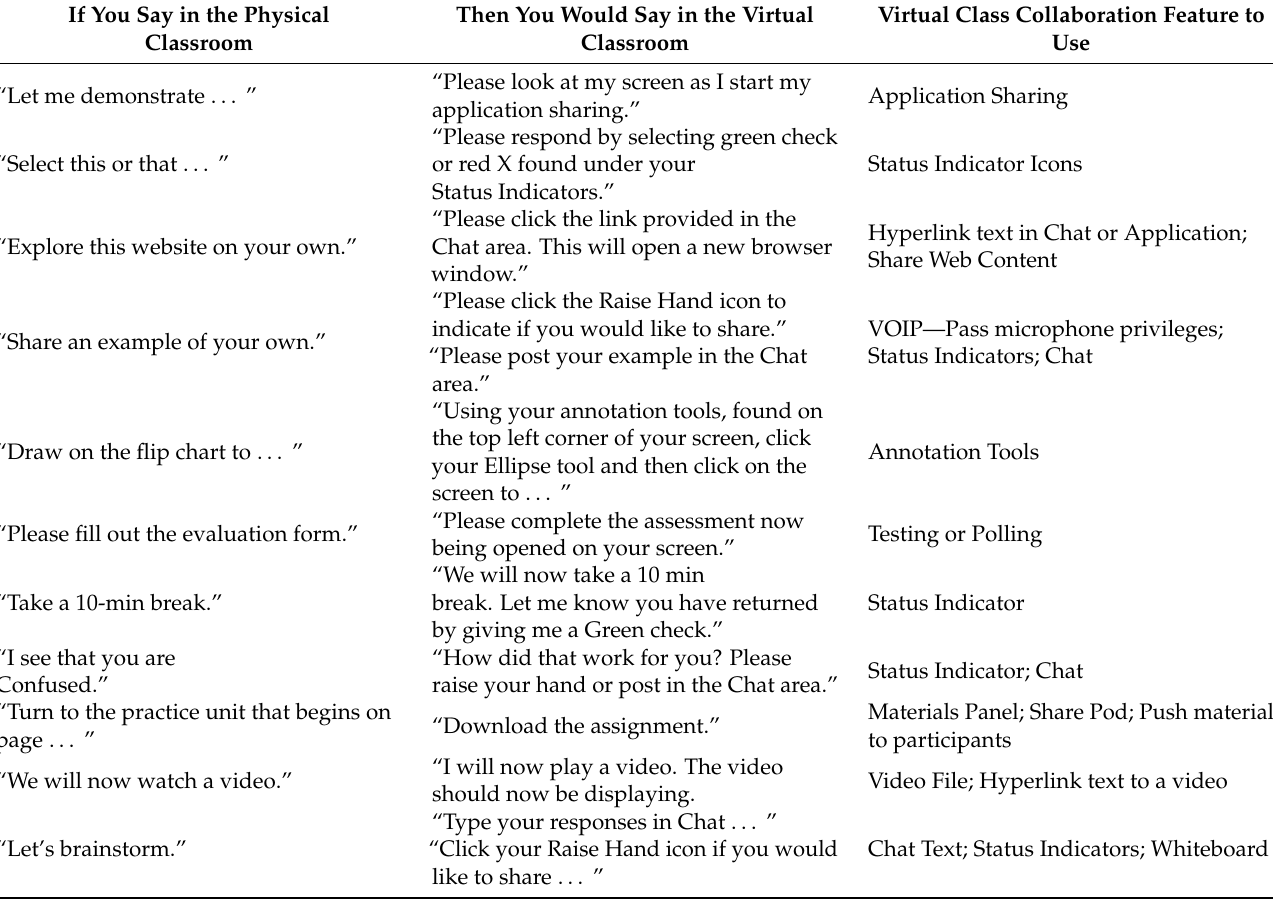
Table 6. Virtual classroom presentation: best